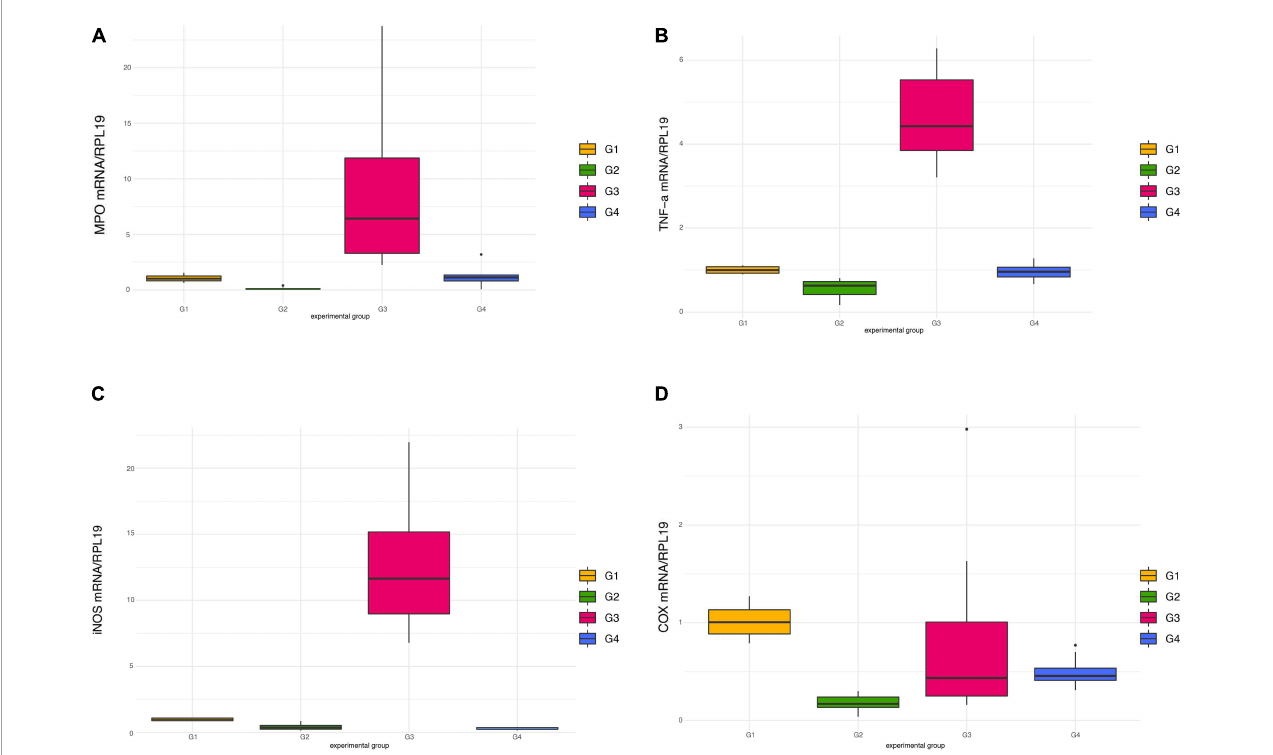
FIGURE5 Pro-inflammatory mediators’ expression in colon tissue in mice of G1, G2, G3, and G4. mRNA levels of MPO (A) , TNF α (B) , iNOS (C) , and COX-2 (D) were all normalized against RPL-19 mRNA.